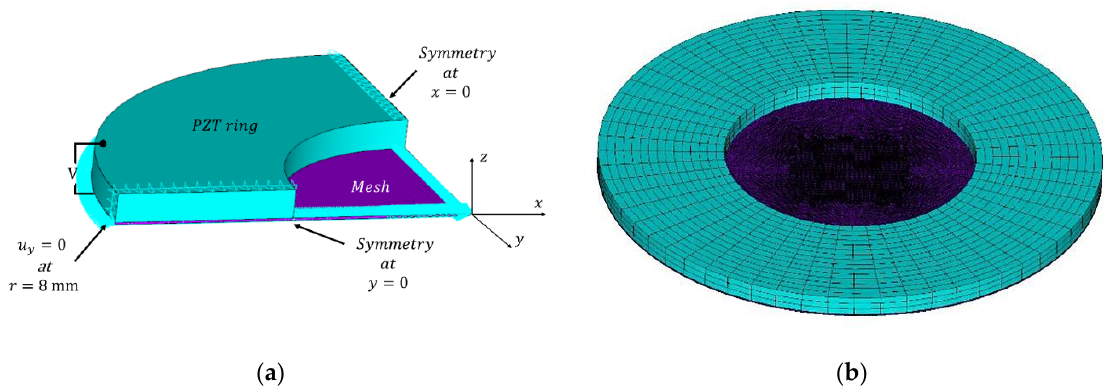
Figure 6. FEM model showing ( a ) a sectional view of the atomizer and boundary conditions and ( b ) mesh of the system. Table 2. Piezoelectrical properties of the PZT ring [14].